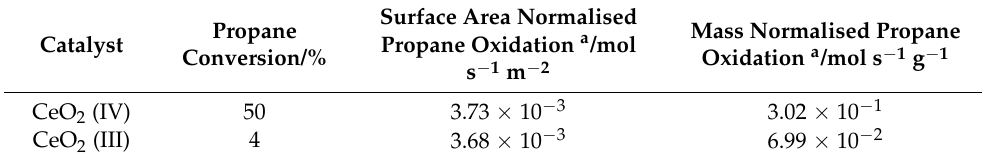
Figure 11. Catalyst activity for propane total oxidation in the presence of water vapour: (Circle) CeO 2 (IV) and (Triangle) CeO 2 (III). Conditions: 5000 ppm propane in air, GHSV = 45,000 h − 1 , 5% Water Saturation. Table 4. Mass normalised and surface area normalised catalytic activity of CeO 2 (IV) and CeO 2 (III) catalysts for propane total oxidation.